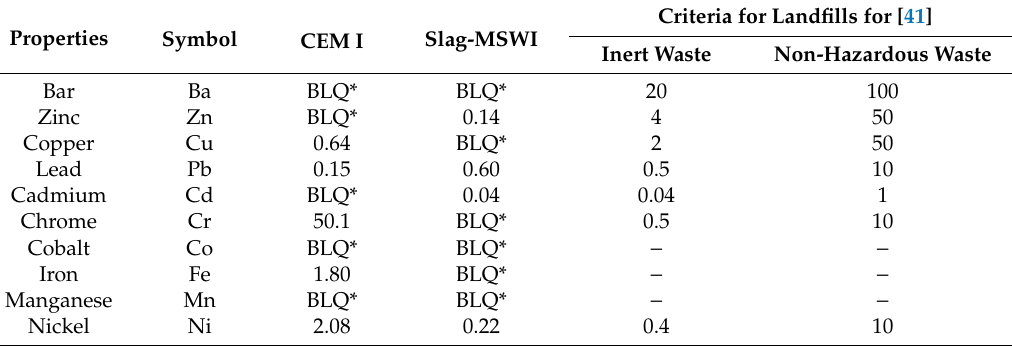
Table 7. Content of heavy metals in water extracts from the slag tested, expressed in mg /